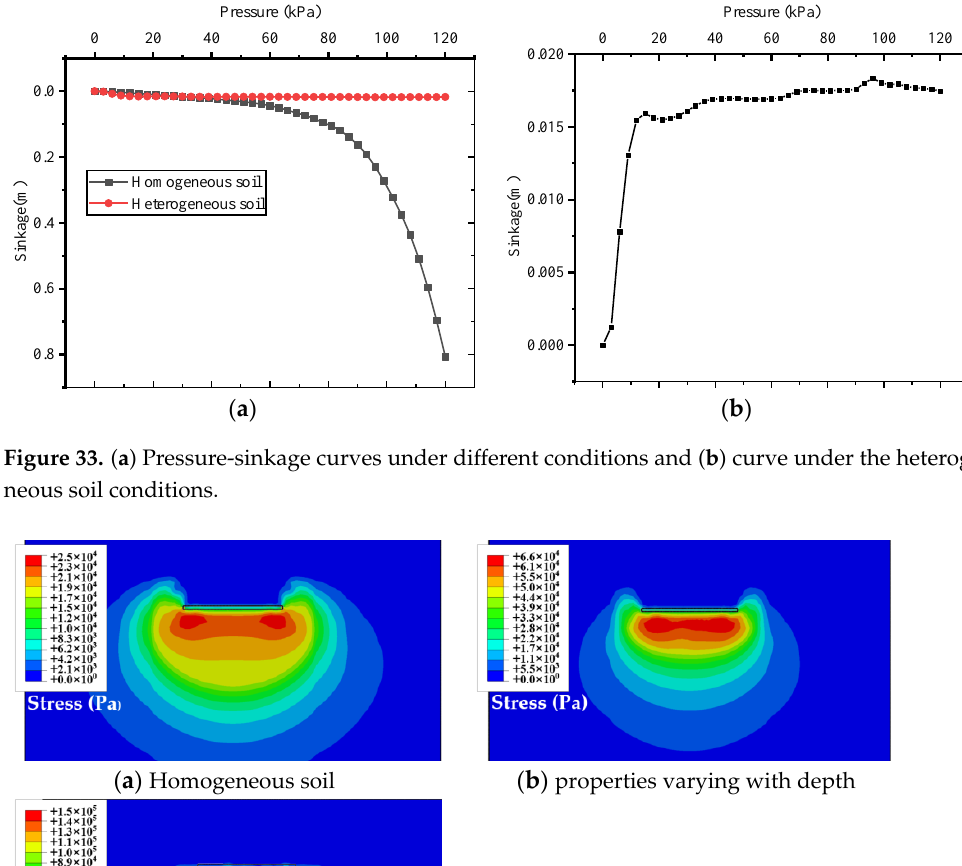
Figure 33. ( a ) Pressure-sinkage curves under different conditions and ( b ) curve under the heteroge- neous soil conditions.